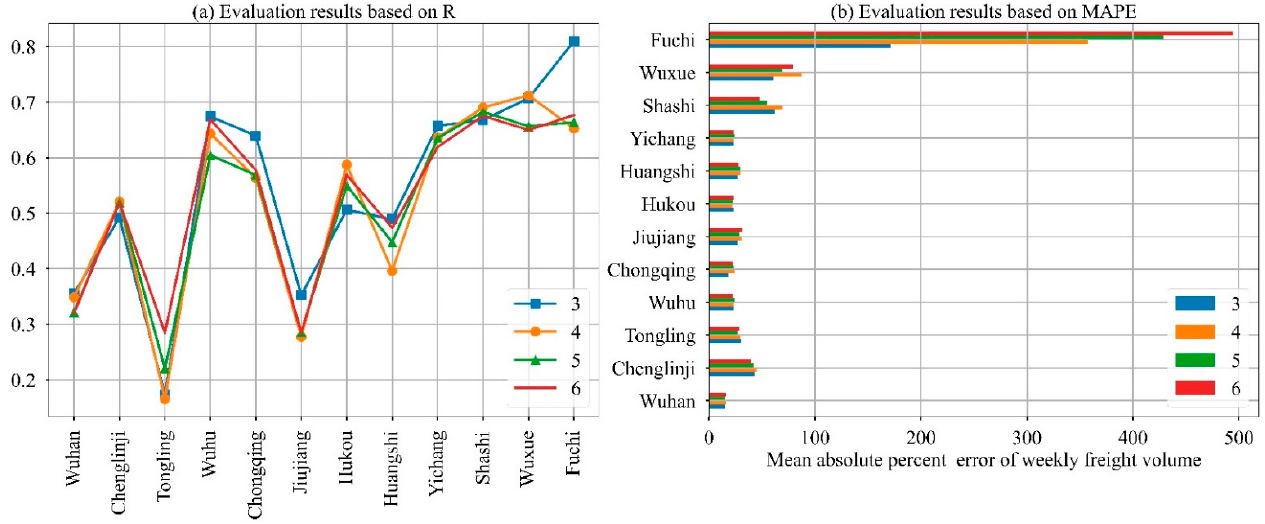
Figure 9. Evaluation results of predictions, based on single-stage GBDT forecasting model with different m dimensions.